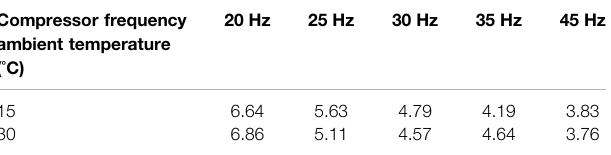
TABLE 4 | Maximum COP for different compressor frequencies and ambient temperatures.